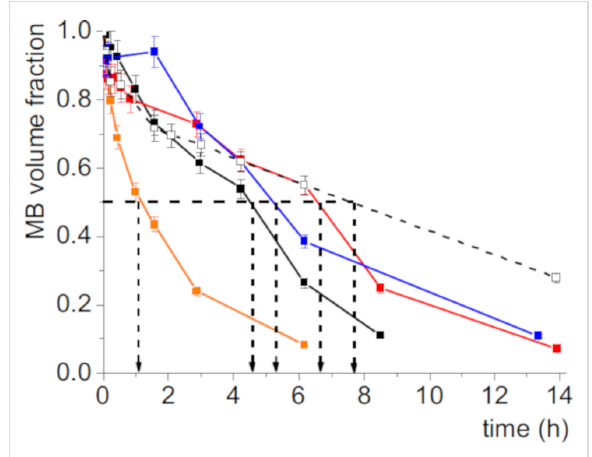
Figure 7: Time evolution (25 °C) of the volume fraction of the DPPC microbubbles (dotted grey) and of the DPPC microbubbles incorporat- ing various IONPs: IONP@C 2 H 5 OEG 8 (black); IONP@C 2 F 5 OEG 8 (red); IONP@C 4 H 9 OEG 8 (orange); IONP@C 4 F 9 OEG 8